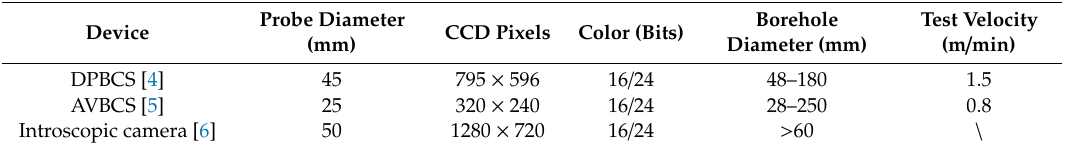
Table 1. Technical specifications of di ff erent